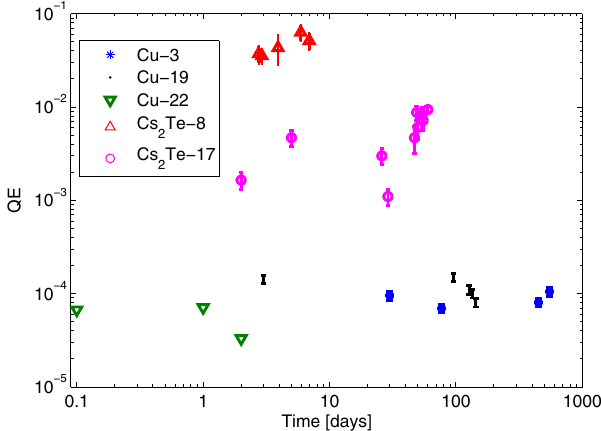
FIG. 2. Quantum efficiency evolution of the five photocathodes tested at the SwissFEL Injector Test Facility. Time zero indicates the beginning of operation for each cathode